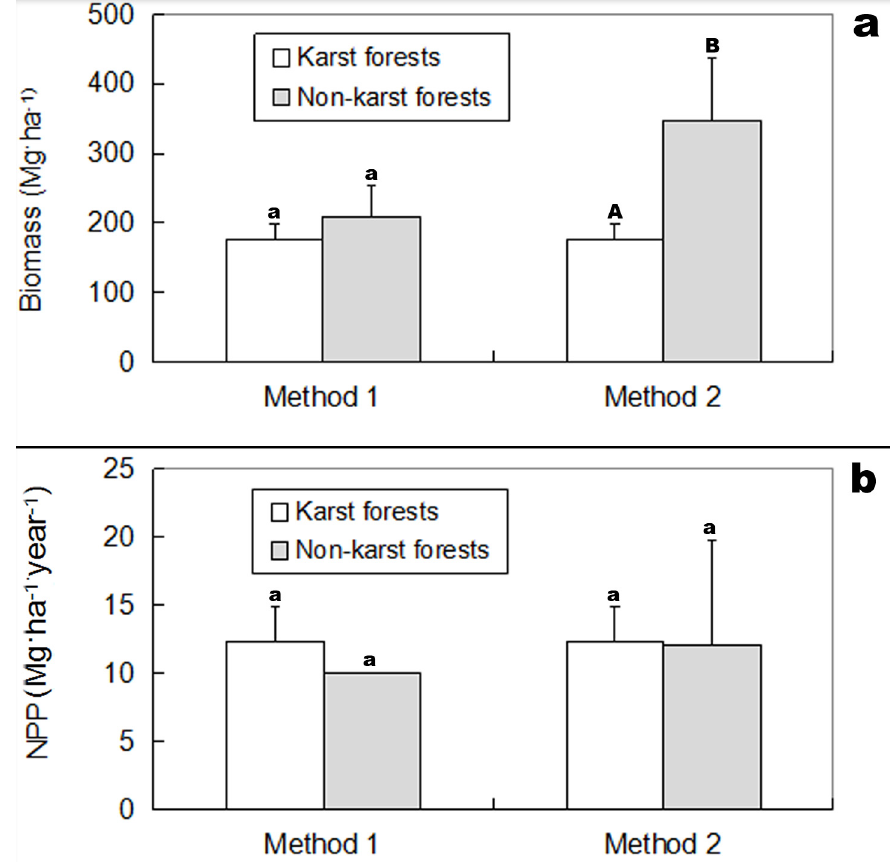
Figure 5. Comparisons of biomass of mature forests ( a ) and NPP of all forests ( b ) in karst and non ‐ karst regions. Method 1: biomass and NPP discrepancies between karst and non ‐ karst subtropical mixed evergreen ‐ deciduous broadleaved forests; method 2: biomass and NPP discrepancies between karst and non ‐ karst forests within a latitude interval of 25° to 27°. Biomass and NPP values with different letters between karst and non ‐ karst forests are significantly different ( t ‐ test, p > 0.05 or p < 0.01).